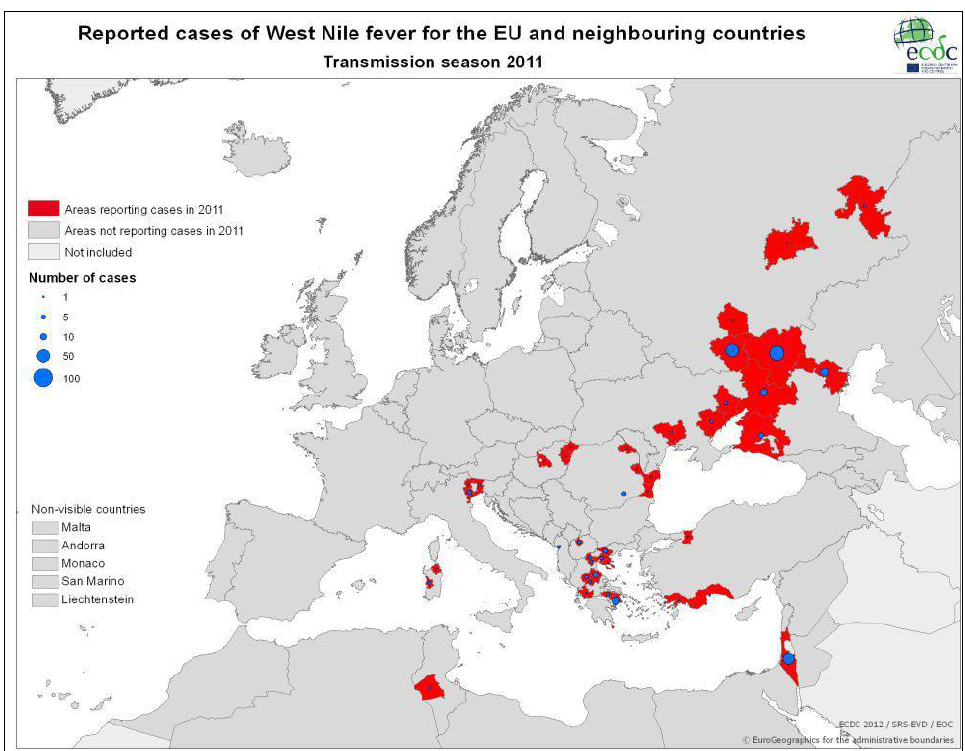
Figure 4. WNV human cases in EU and neighboring countries, 2011 (Source: